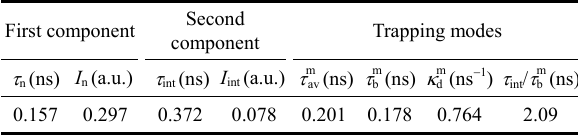
Table 5 PAL trapping modes for MgGa 2 O 4 :Mn 2+ ,Eu 3+ ceramics defined in respect to MgGa 2 O 4 :Mn 2+ ceramics within